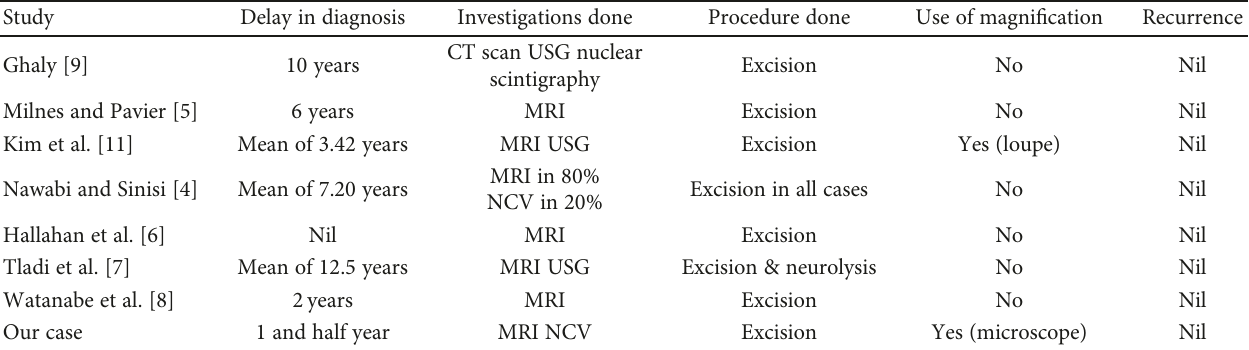
Table 1: Tabulation of similar studies on schwannomas mimicking tarsal tunnel syndrome and comparing the delay in diagnosis, investigations performed, procedures done, use of magni fi cation, and the